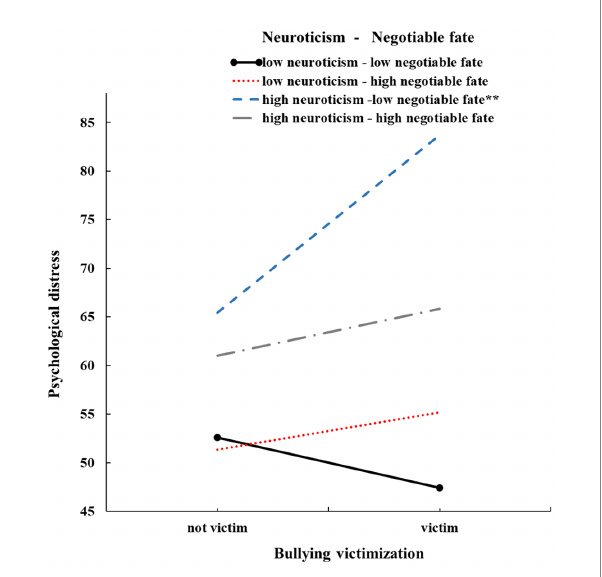
FIGURE 3 Three-way interaction effect of bullying victimization, neuroticism, and negotiable fate on adolescent depression. The y-axis of Figure 3 does not start at